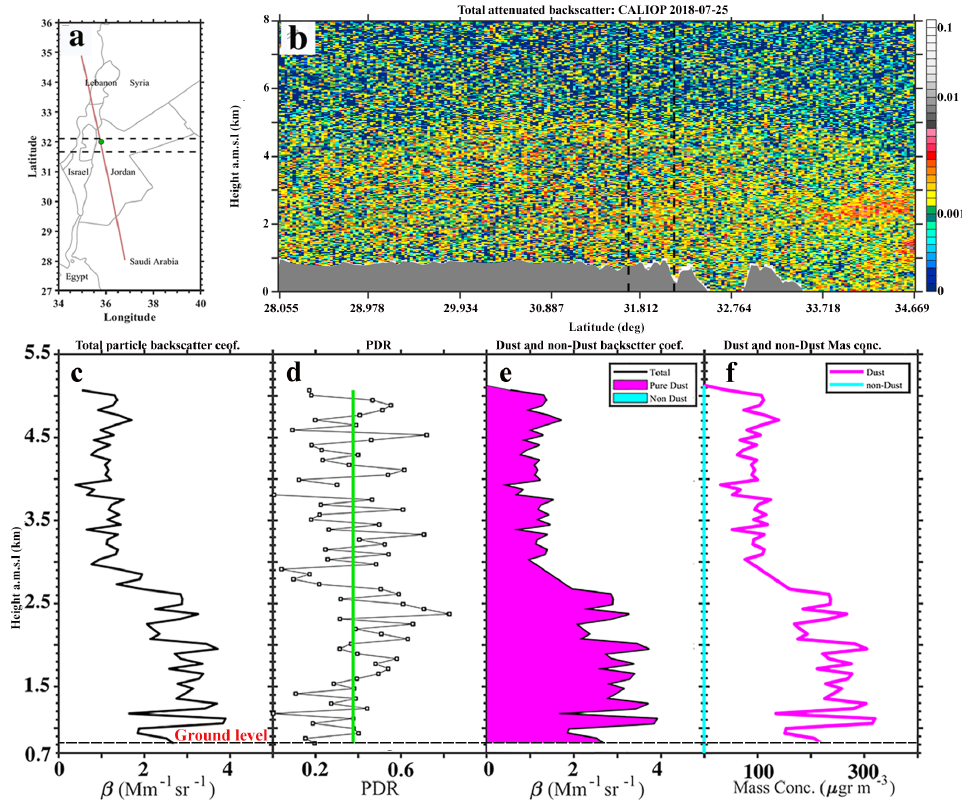
Figure 7. ( a ) CALIPSO satellite ground track (red line) and the location of Amman (green circle) on 25 July 2018. ( b ) Cross-section of attenuated backscatter coefficient in arbitrary units (AU) by CALIPSO over Amman and the neighboring area. Vertical profile of optical and physical properties of aerosols within the region determined by a dashed line in Figure 7a in ( c ) total particle backscatter coefficient. ( d ) Particle depolarization ratio. ( e ) Dust and non-dust backscatter coefficient. ( f ) Dust and non-dust mass